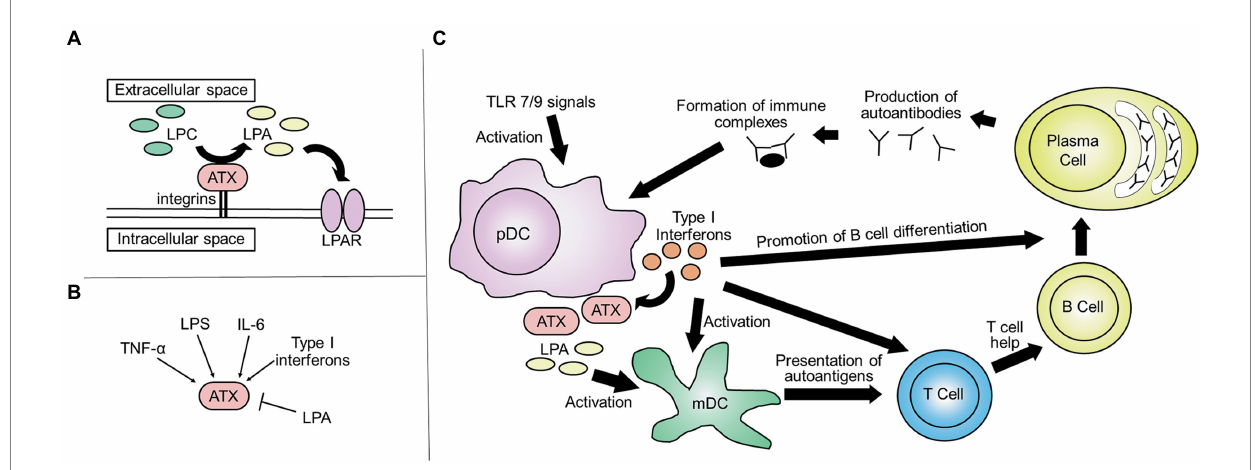
FIGURE 1 An Overview of ATX. (A) The ATX-LPA axis: ATX is a lysophospholipase that mainly catalyzes the production of LPA from lysoglycerophospholipids, such as lysophosphatidylcholine. (LPC, lysophosphatidylcholine; ATX, autotaxin; LPA, lysophosphatidic acid; LPAR, LPA receptor). (B) Regulation of ATX expression: the expression of ATX is induced by TNF, IL-6, LPS, and type I interferons and inhibited by LPA. (TNF, tumor necrosis factor; IL-6, interleukin-6; LPS, lipopolysaccharide). (C) ATX and the pathogenesis of SLE: pDCs are activated by TLR7 and TLR9 signals, resulting in the production of type I interferons. Type I interferons induce the production of ATX and thus the production of LPA. This results in the activation of mDCs, which present autoantigens to T cells and activate them. Together, this leads to the maturation of B cells and the production of autoantibodies. Immune complexes further enhance the activation of pDCs, resulting in a positive feedback loop, contributing to the organ damage in SLE (pDC, plasmacytoid dendritic cell; TLR, toll-like receptors; mDC, myeloid dendritic